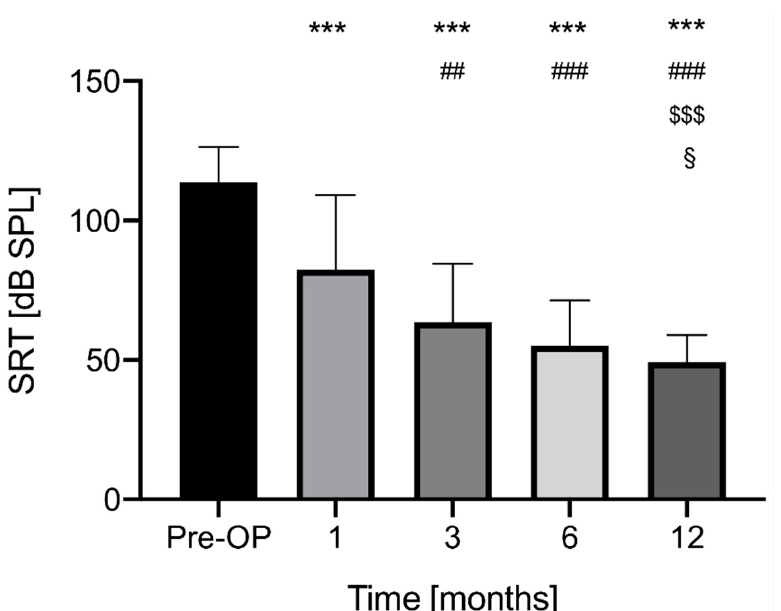
Figure 2. Speech reception thresholds (Freiburger speech test) preoperatively, at 1, 3, 6 and 12 months postoperatively in the whole patient cohort. Significant differences ( p < 0.05) are indicated in comparison with * vs. Pre-OP, # vs. 1 month, $ vs. 3 months, § vs. 6 months. Significance levels are indicated as **/##/$$/§§ if p < 0.005 and as ***/###/$$$/§§§ if p <